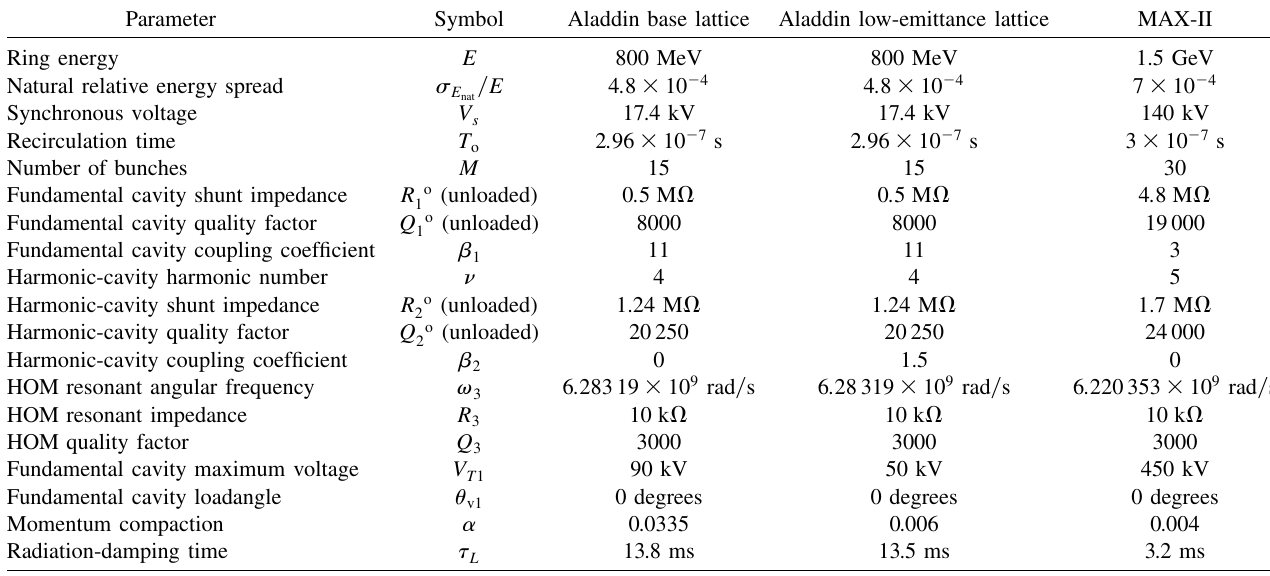
TABLE I. Parameters for the Aladdin base and low-emittance lattices, and MAX-II with the new rf system. The shunt impedance value equals the resistance of the equivalent RLC circuit, and is equal to one-half of the ‘‘linac’’ definition of shunt impedance. The HOM parameters describe a parasitic